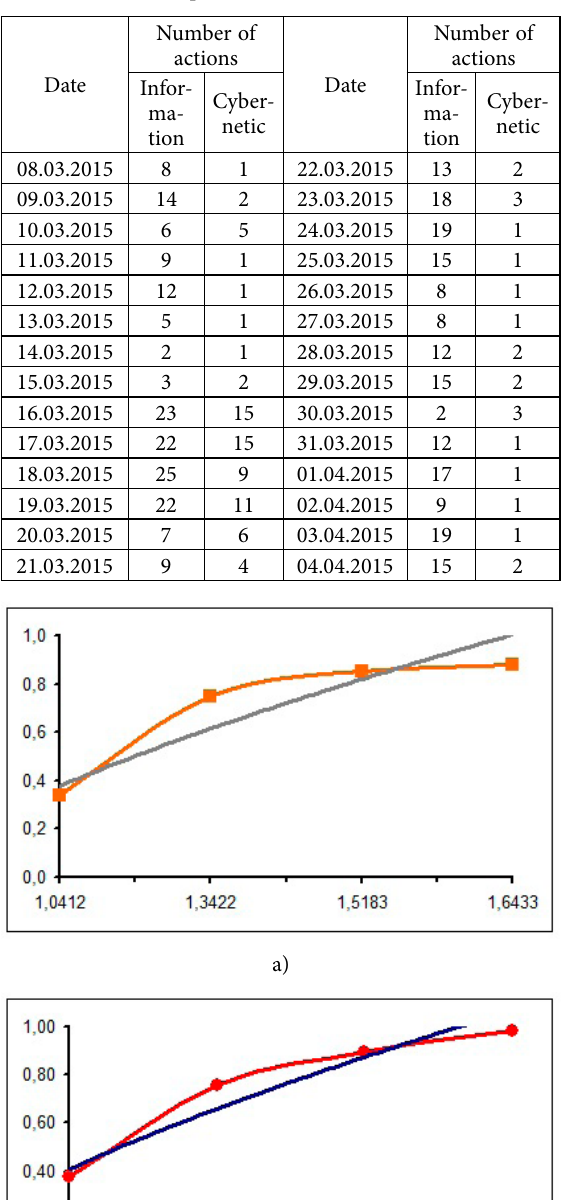
Table 2. The set of input data